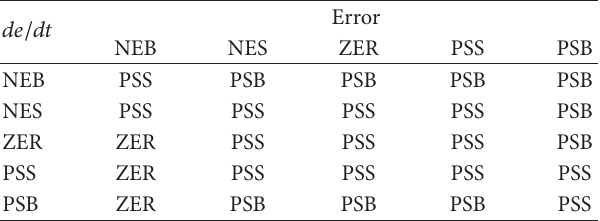
Table 3: If-then rule of fuzzy logic controller for 𝐾 𝑆 .